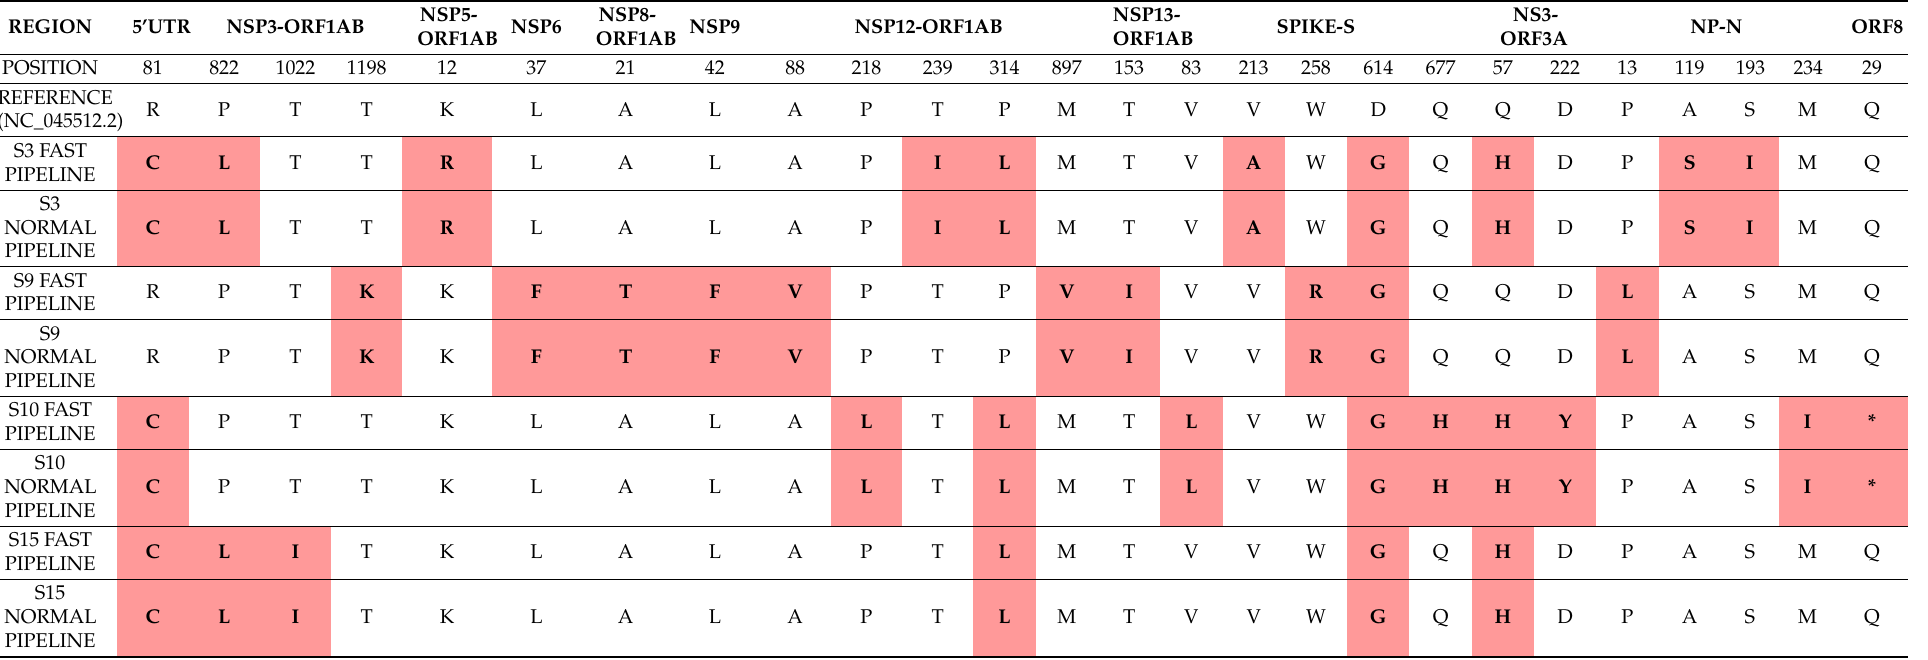
Table 13. Identified Amino Acids Mutations in Batch 2 Samples Running All